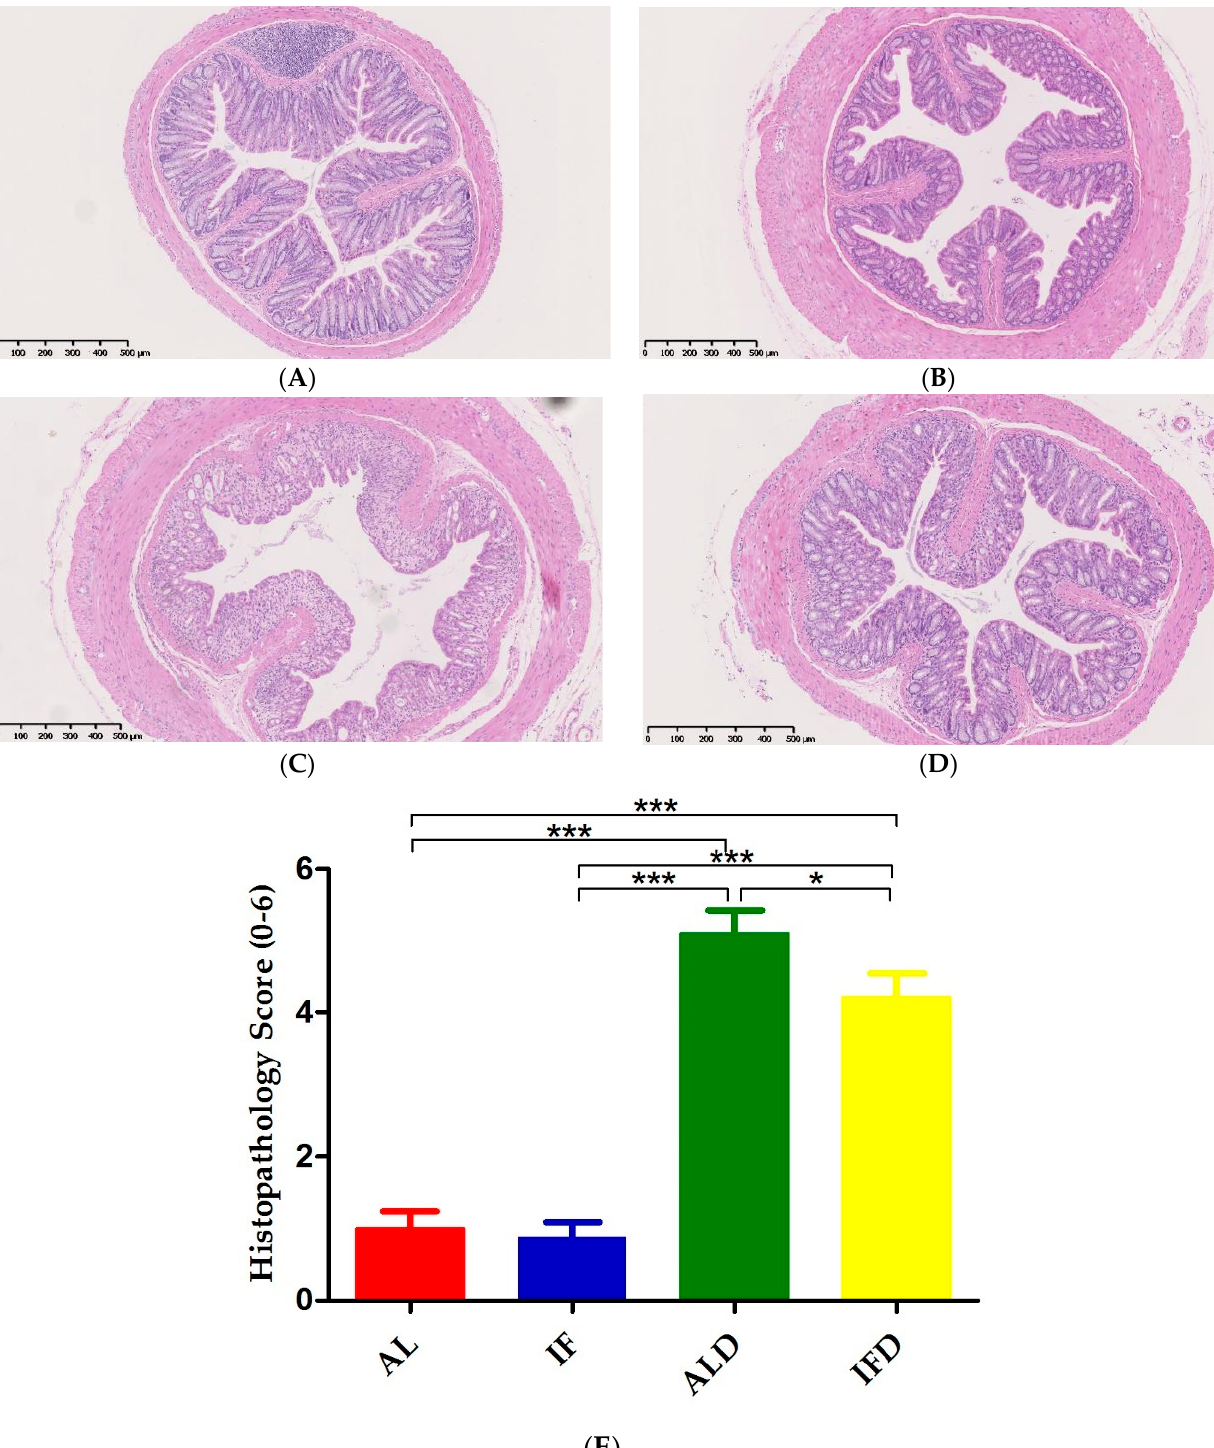
Figure 6. IF ameliorated DSS-induced intestinal mucosal damage: ( A ) representative images of the colon histology in AL group; ( B ) representative images of the colon histology in IF group; ( C ) representative images of the colon histology in ALD group; ( D ) representative images of the colon histology in IFD group; and ( E ) histopathology scores of the four groups. AL: ad libitum-fed group; IF: intermittent fasting group; ALD: ad libitum-fed group with DSS; IFD: intermittent fasting group with DSS. * p < 0.05, p < 0.01, *** p < 0.001.